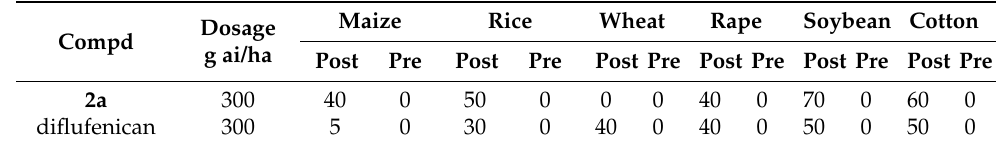
Table 2. Post- and pre-emergence crop selectivity results of compounds 2a and